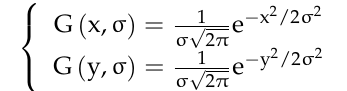
Figure 2. Curve smoothing for two different shapes. ( a ) Shape A, ( b ) Shape B. The red line is the original contour, and the blue line is the Gaussian smoothing result.